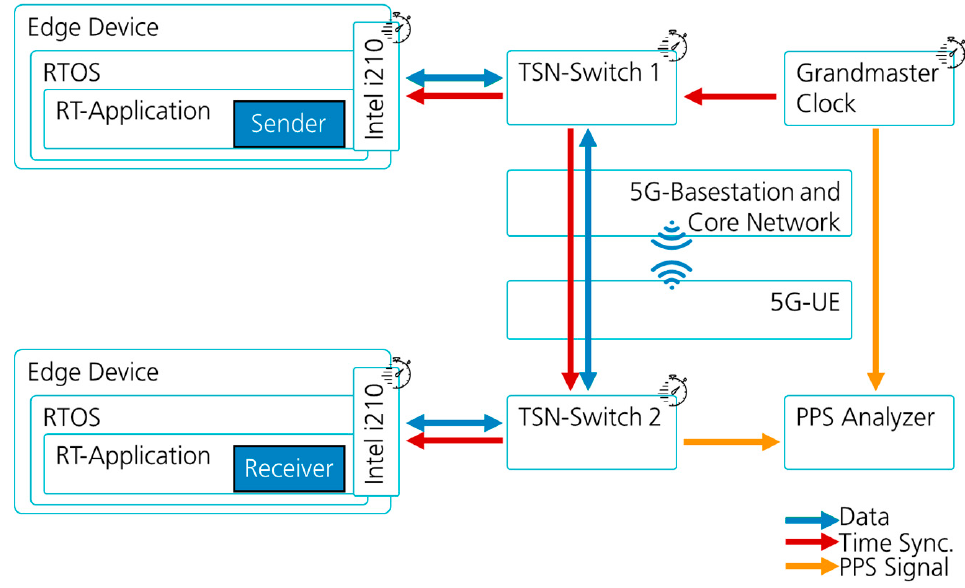
Figure 8. Overall Architecture of the Prototype of 5G integrated with TSN.